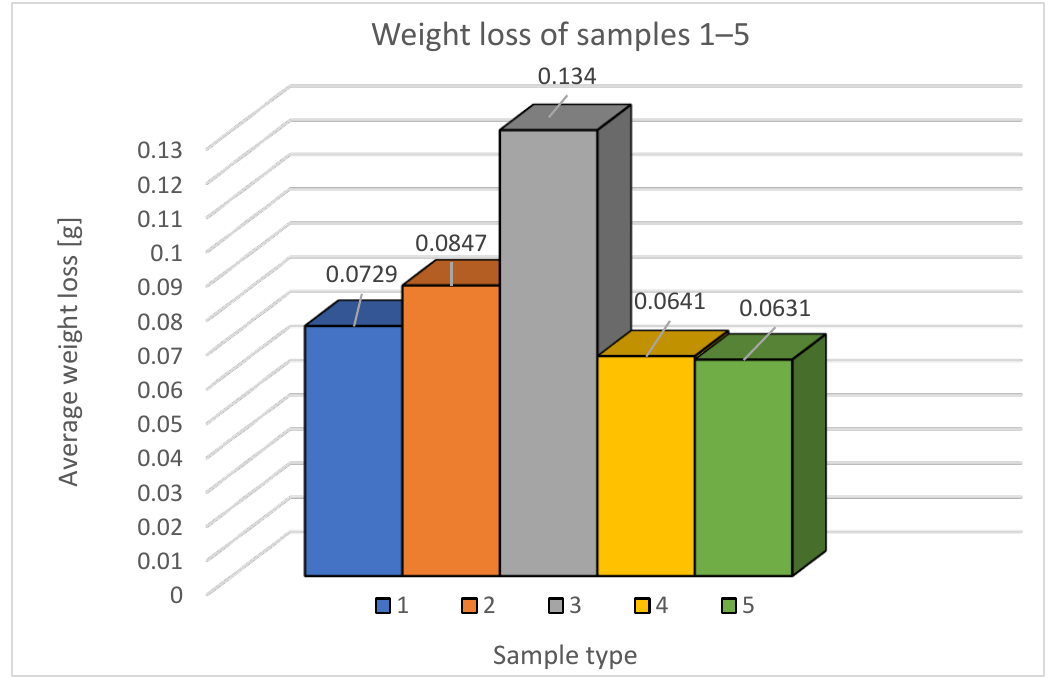
Figure 6. Weight loss in individual Samples 1 – 5 (X-orientation).